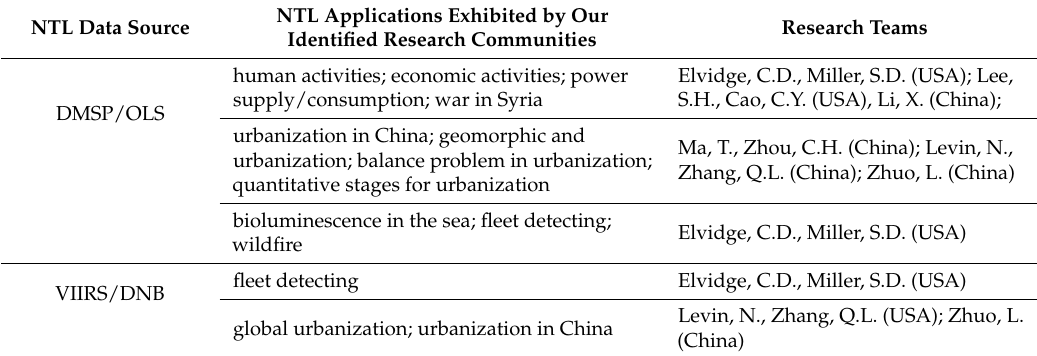
Table 7. The NTL applications and